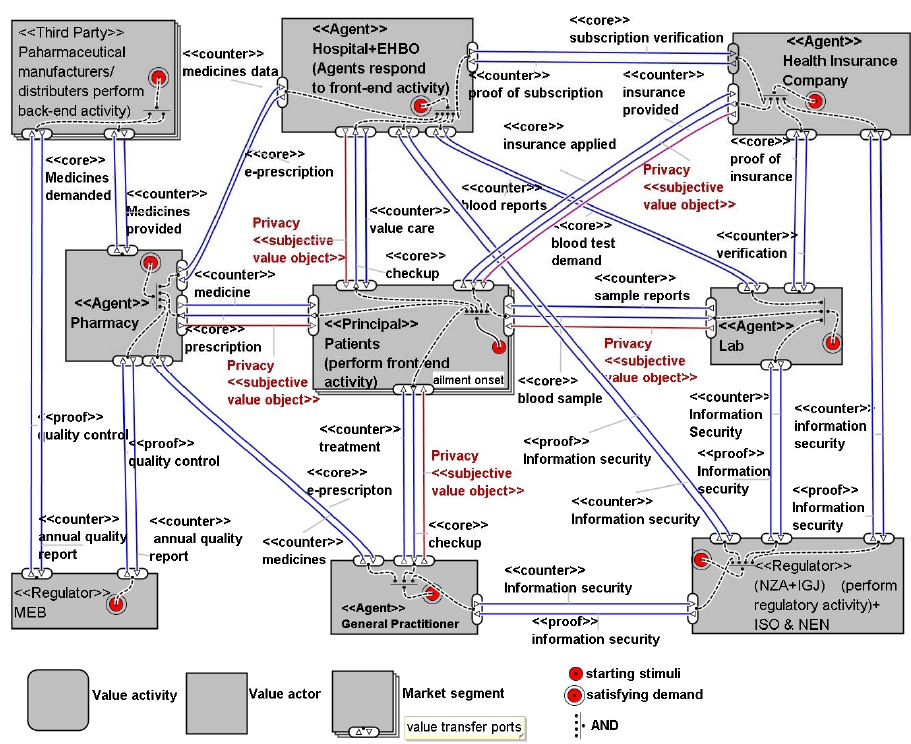
Figure 3. Privacy assurance evaluation at